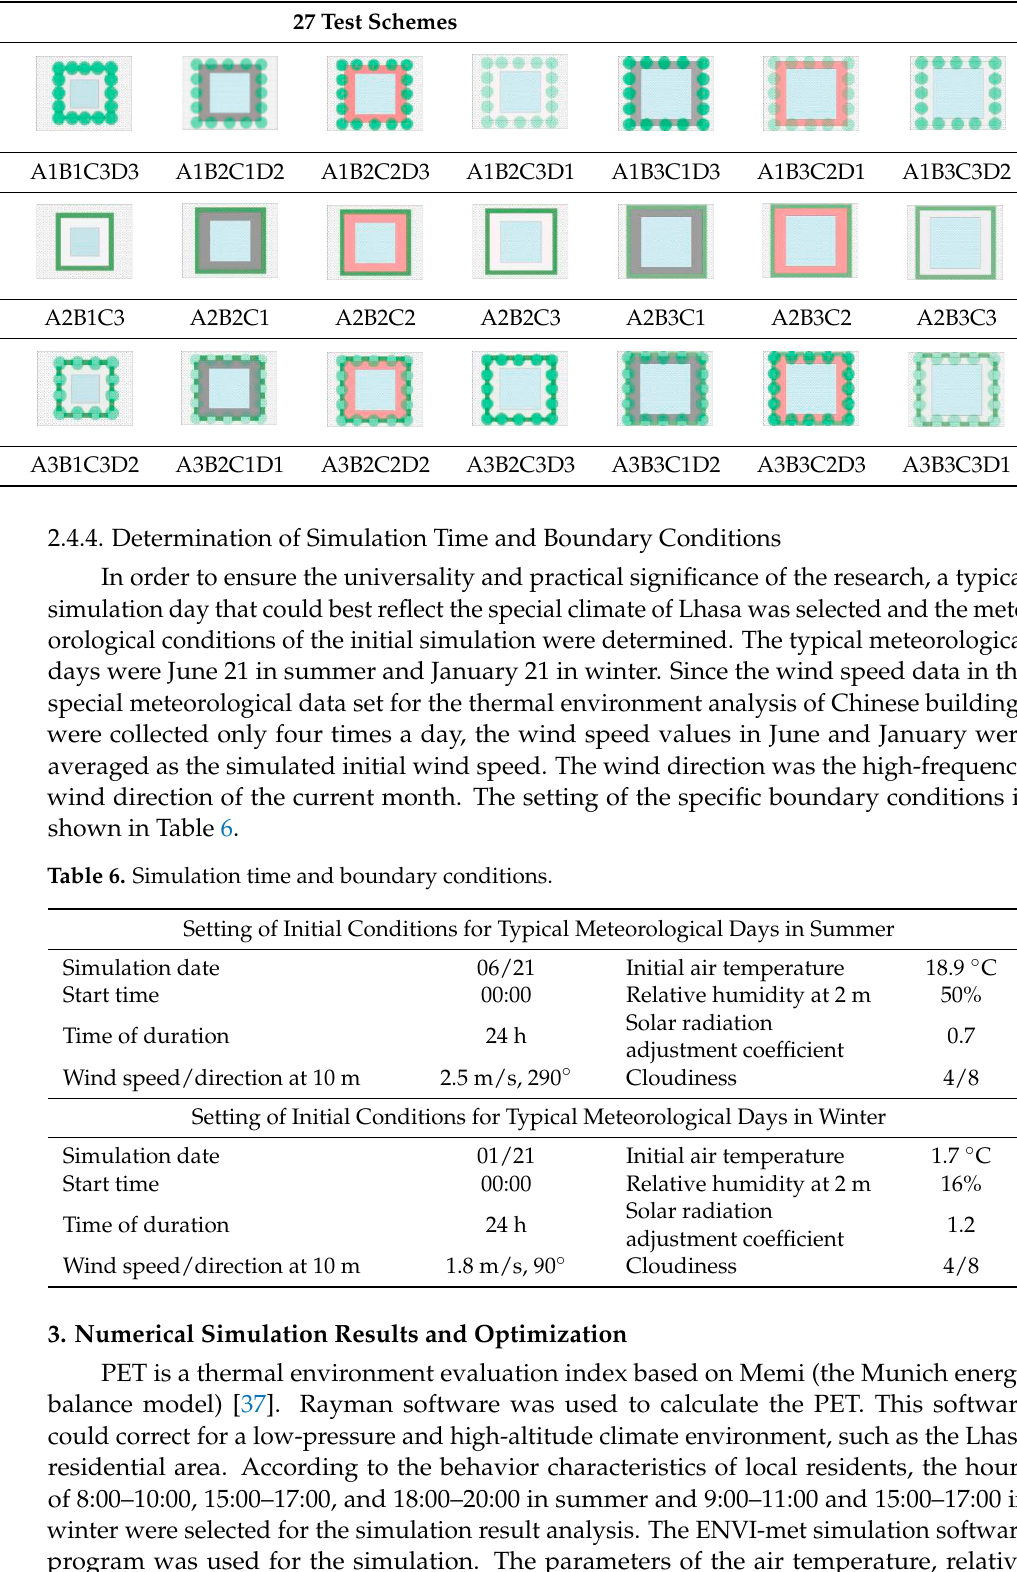
Table 5. Plane diagram of 27 test schemes.